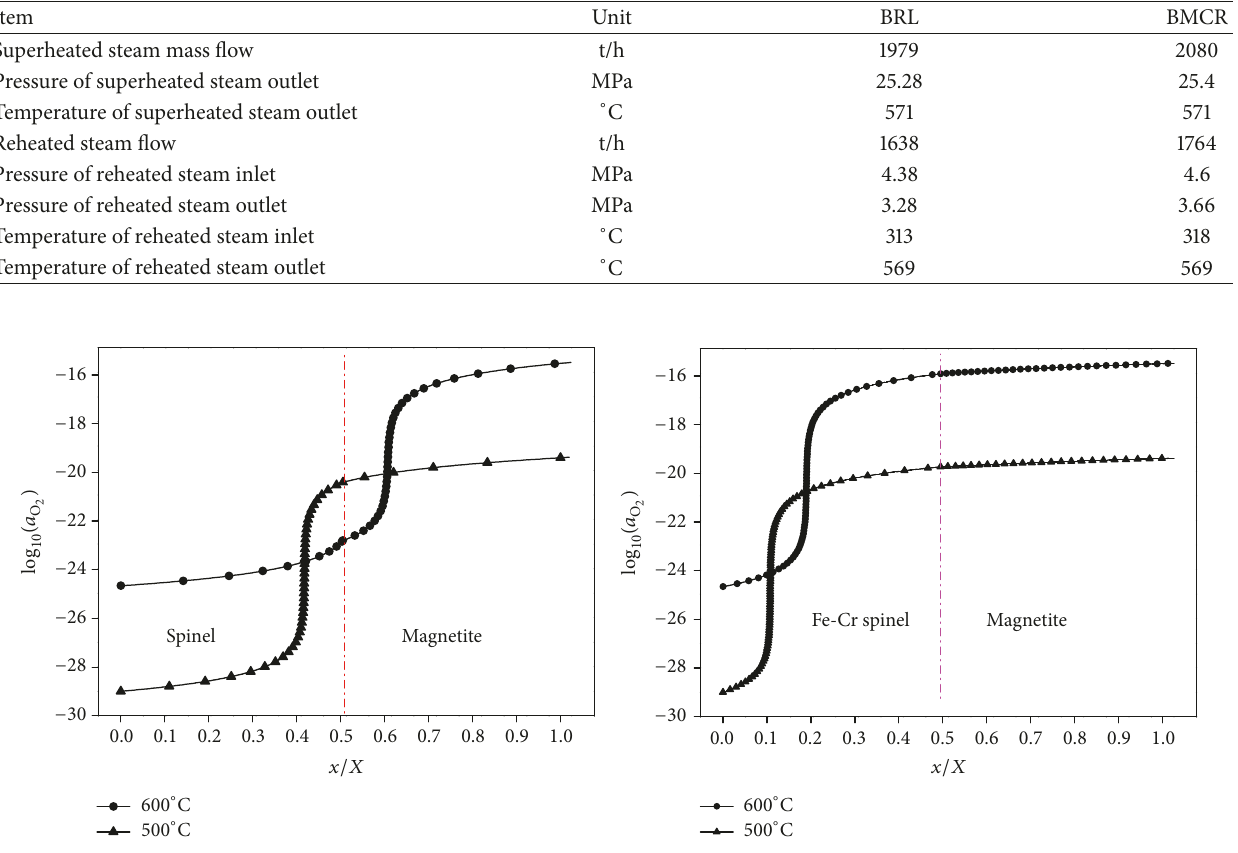
Table 4: Main thermodynamic parameters of a boiler, for example, calculation.